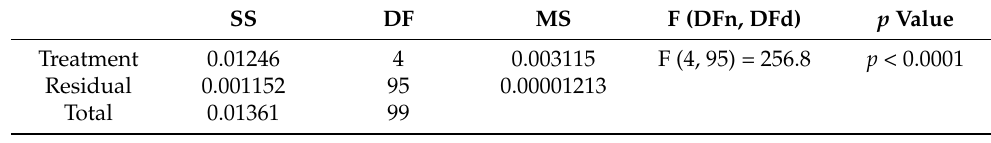
Table 8. One-way analysis of variance test of the achieved results using the first dataset (D1).